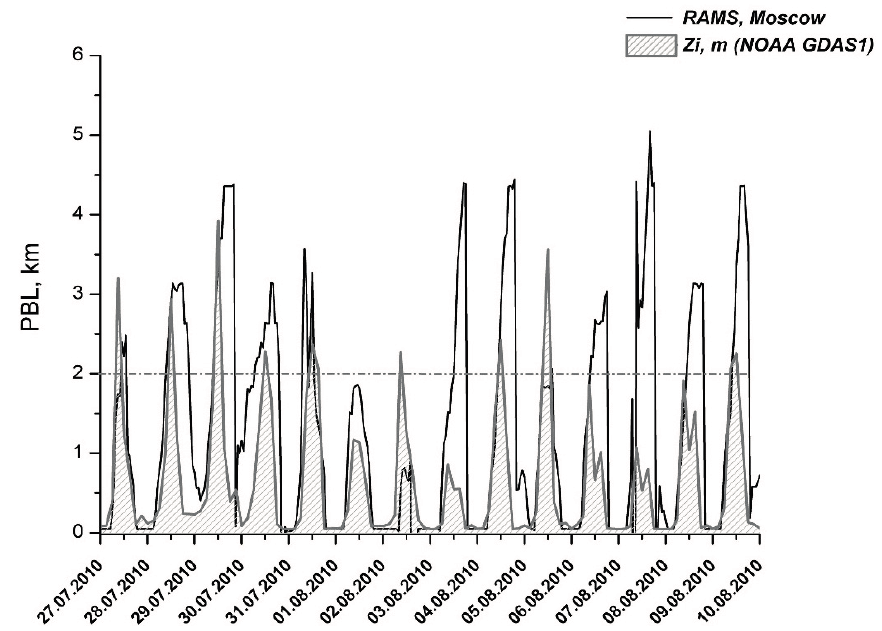
Figure 5. The planetary boundary layer height calculated by RAMS model and from NOAA GDAS meteorological